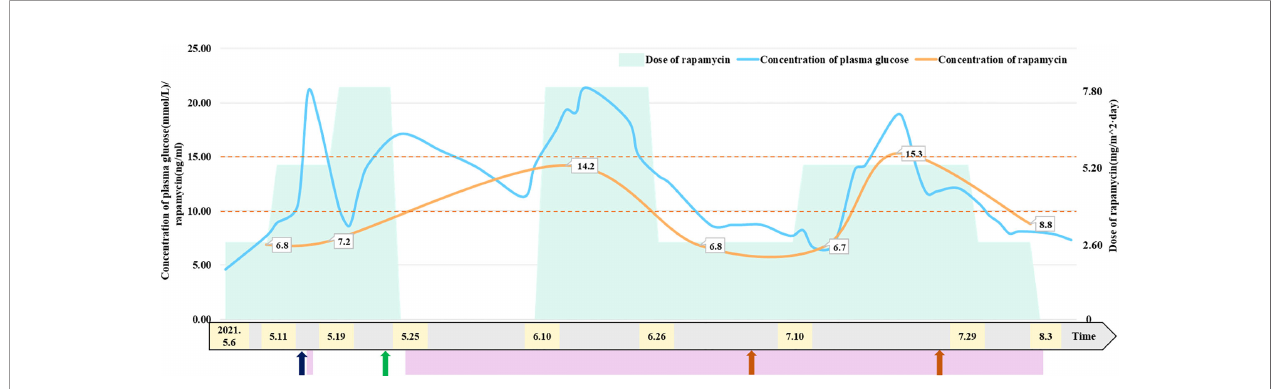
FIGURE 1 | Relationship between dose of rapamycin and concentration of plasma glucose and rapamycin. Patient received insulin treatment to control plasma glucose on May 15 and from May 25 to August 3, 2021. Patient underwent Ommaya insertion and biopsy on May 13, 2021. Patient underwent subtotal resection of tumor on May 23, 2021. Patient received CPT-SIOP-2000 chemotherapy on July 2 and July 26, 2021. The maintaining trough concentration of rapamycin is recommended between 10 to 15 ng/mL. The fi gure indicated that patient ’ s concentration of plasma glucose has a positive correlation with the dose of